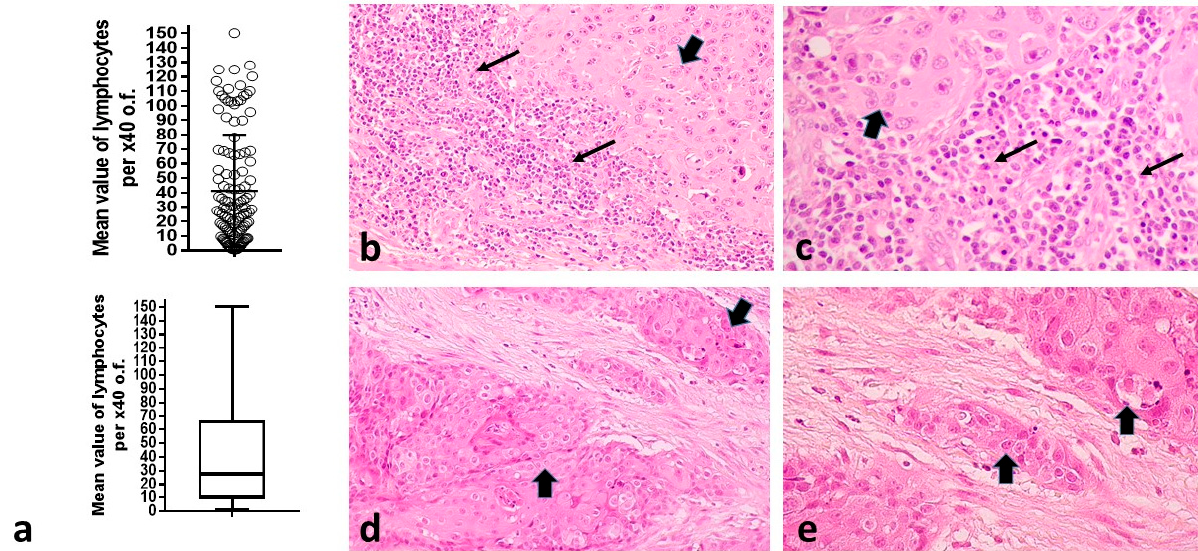
Figure 1. TILs in HNSCC: ( a ) Distribution of TILs per ×40 o.f. among 121 tumors (showing also the mean value and standard deviation), complemented by a box and whiskers figure showing the median value, range and the 25th and 75th percentile positions. Bars show the median value and standard deviation; ( b , c ) Typical hematoxylin and eosin sections of HNSCC in ×20 and ×40 magnification, respectively, showing intense infiltration of the tumor stroma by TILs; ( d , e ) Typical hematoxylin and eosin sections of HNSCC in ×20 and ×40 magnification, respectively, with lack of infiltration of the tumor stroma by TILs. Thin arrows show lymphocytes, while thick arrows show cancer cell nests. (HNSCC = squamous cell head–neck tumors, o.f. = optical fields, TILs = tumor-infiltrating lymphocytes). Using the median value of 27.5 (<median vs. ≥ median), patients were grouped into two TIL density categories: low vs. high TIL